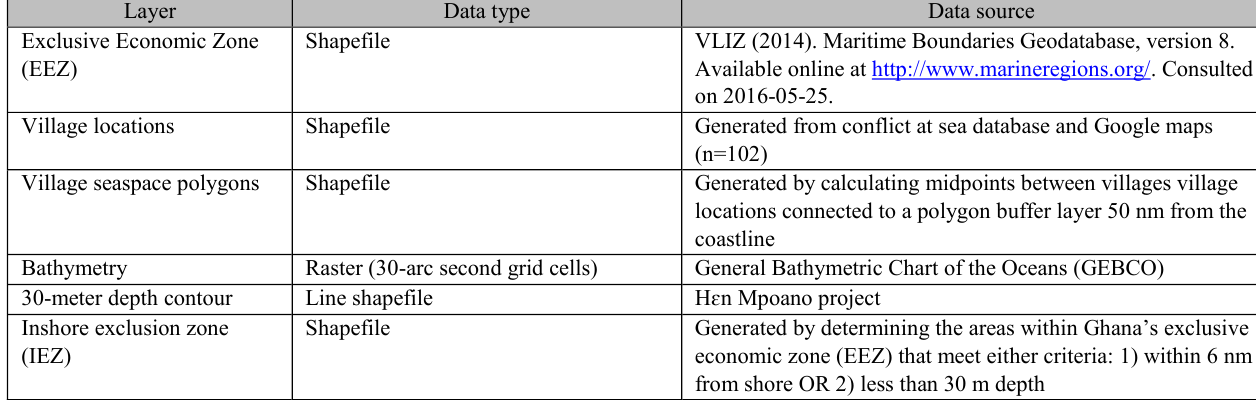
Table A1.3 : Information on the sources of data layers included in spatial